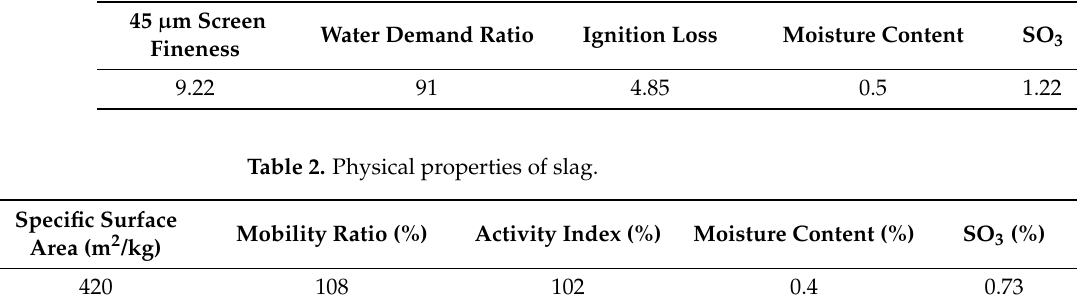
Table 1. Physical properties of fly ash (%).